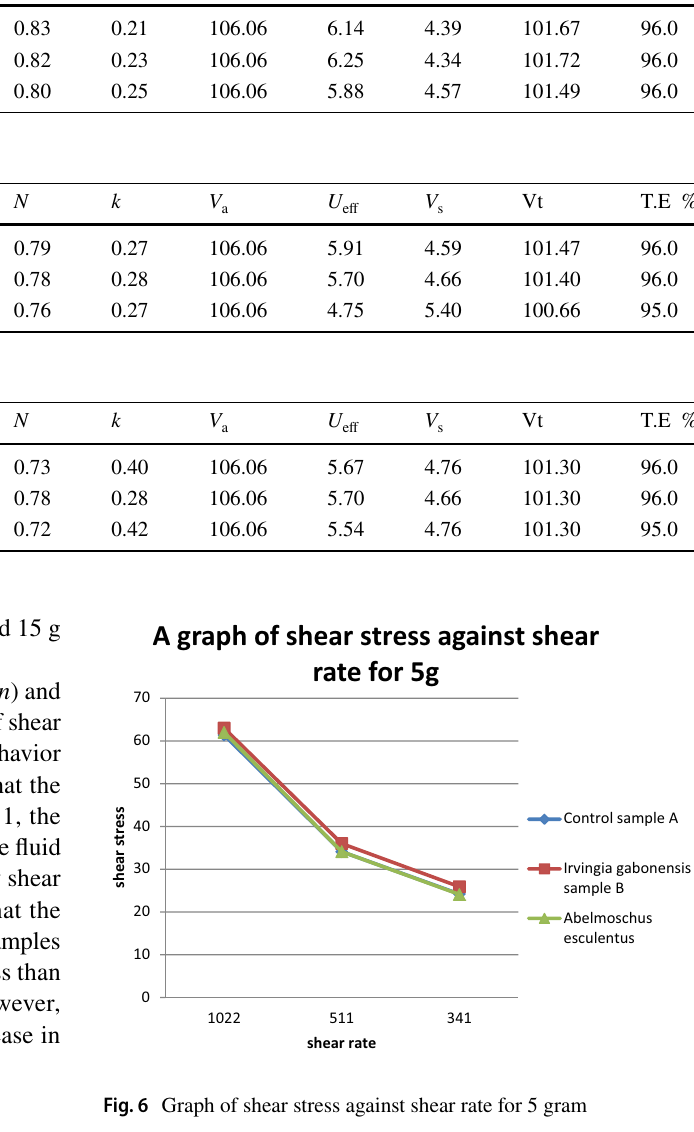
Table 19 Evaluation of V V s and T.E using 8 g